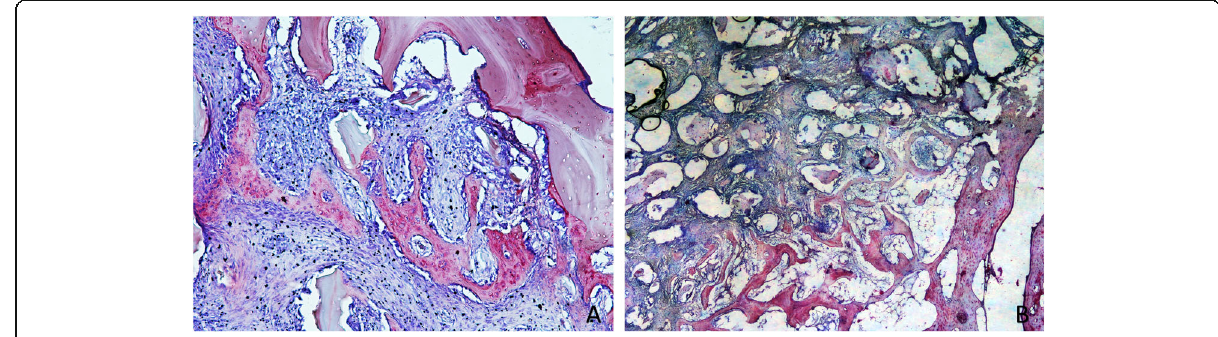
Fig. 8 Photomicrographs of decalcified sections. a Untreated site. Woven bone formed from the sinus walls after 1 week of healing. b Treated site. After 8 weeks, woven bone was still found forming ridges towards residues of provisional matrix, showing that the healing was not completed yet. Scarlet-acid fuchsine and toluidine blue stain. a × 100 magnification. b × 20